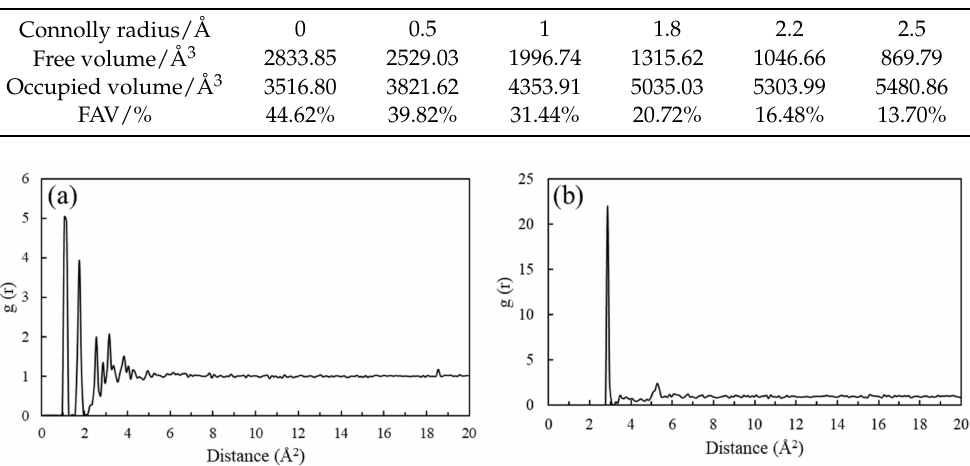
Table 2. Volume parameters measured by probes with a different radius (the total volume is 6350.65 Å 3 ).